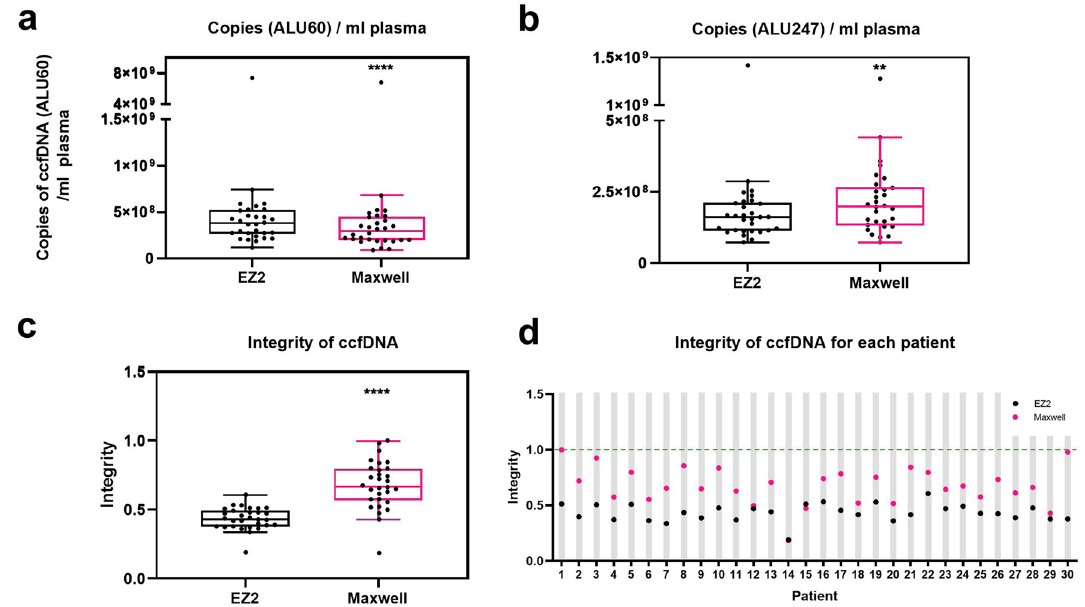
Figure 2. Integrity of circulating cell-free DNA (ccfDNA). Copies per ml plasma of short ( a ) (ALU60) and long ( b ) ALU fragments (ALU247) were quantified by quantitative real-time-polymerase chain reaction (qPCR) in EZ2 ccfDNA field test kit isolates and Maxwell RSC ccfDNA plasma kit isolates. ( c ) The integrity was presented as the ratio between ALU247 and ALU60 copy numbers. ( d ) Integrities of ccfDNA were presented per patient. The central line in the box plot represents the median value and the whiskers are Tukey whiskers. **, p = 0.004; ****, p ≤ 0.0001. n = 30.